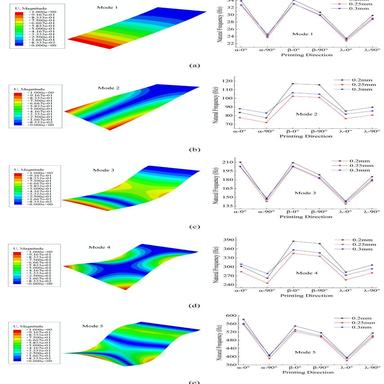
The effects of printing directions and layer thicknesses on natural frequencies of FFF 3D printing plates, (a) mode 1, (b) mode 2, (c) mode 3, (d) mode 4, (e) mode 5.